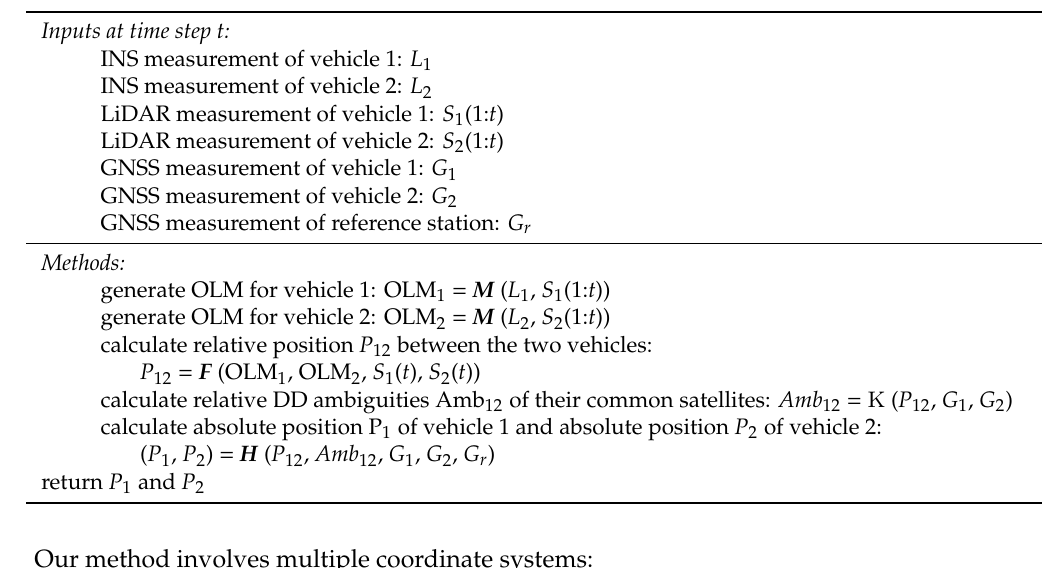
Table 1. Pseudocode of the main procedures in our